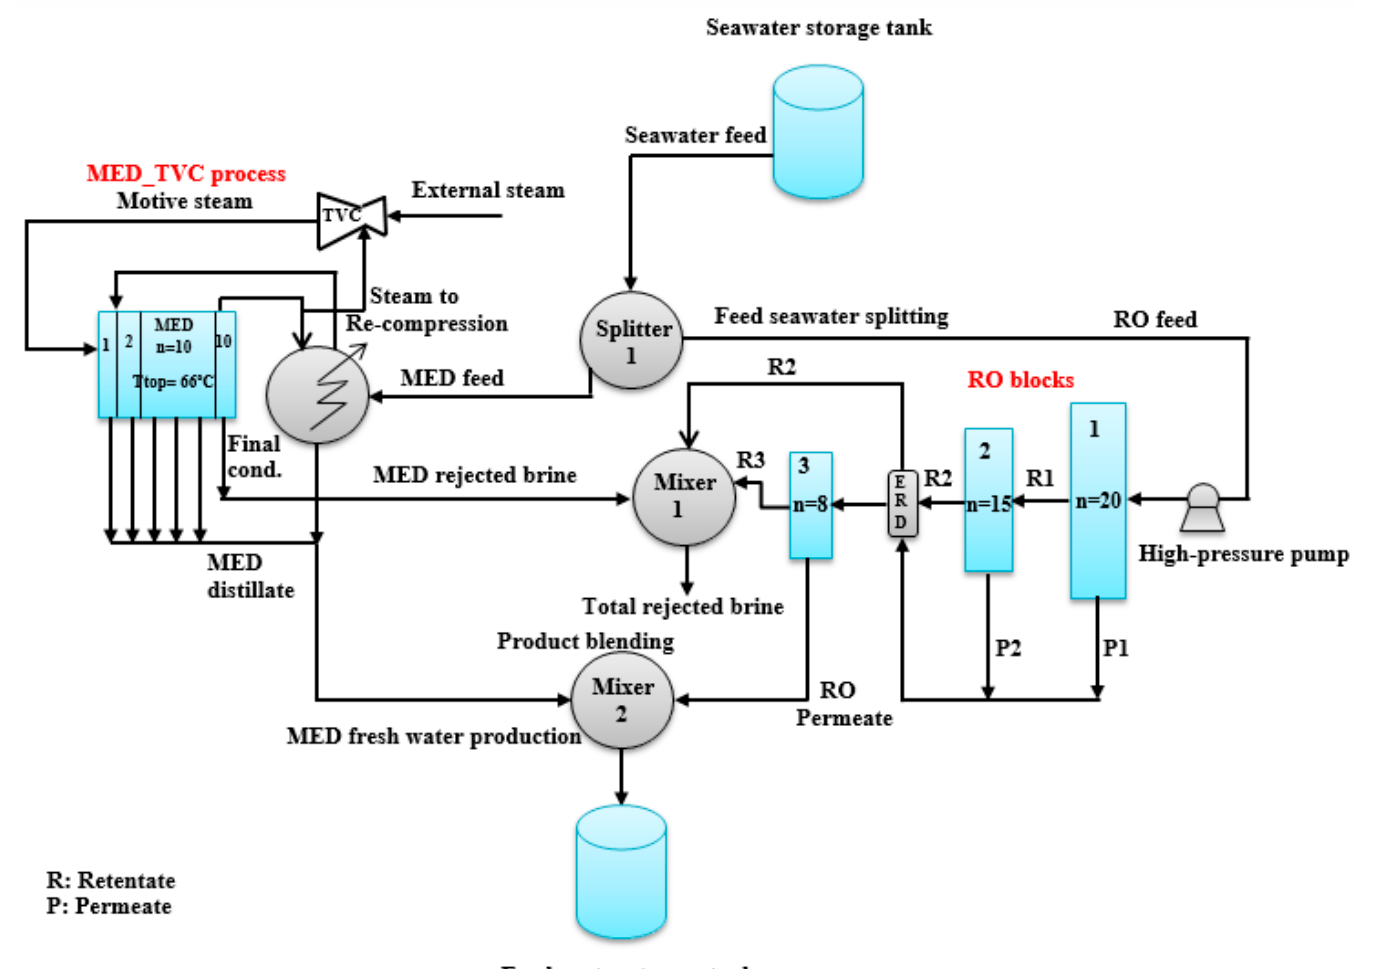
Figure 1. Schematic diagram of a simple integrated system of multi effect distillation and thermal vapour compression and permeate reprocessing reverse osmosis processes.